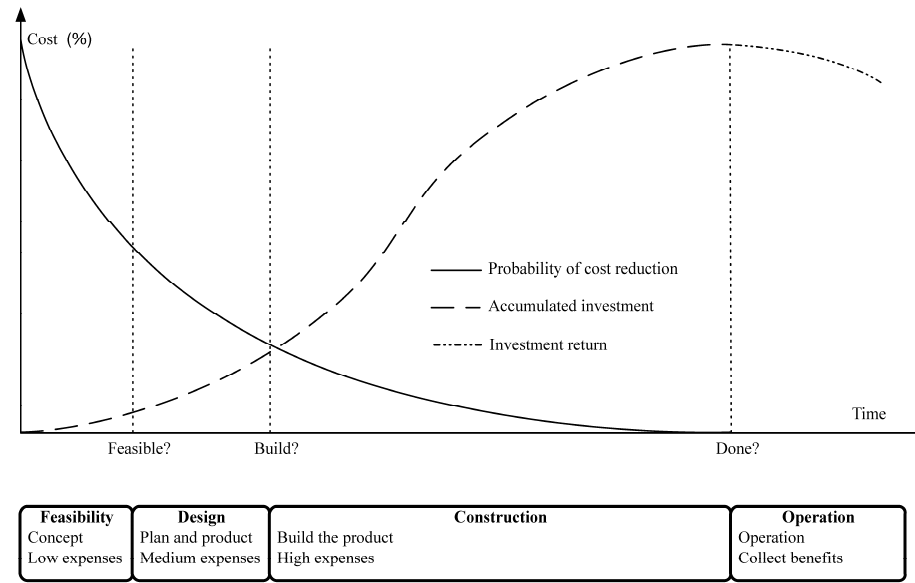
Figure 3. Graph of percentage cost over time demonstrating how early correct decisions may impact cost reduction (adapted from Smith et al. ,